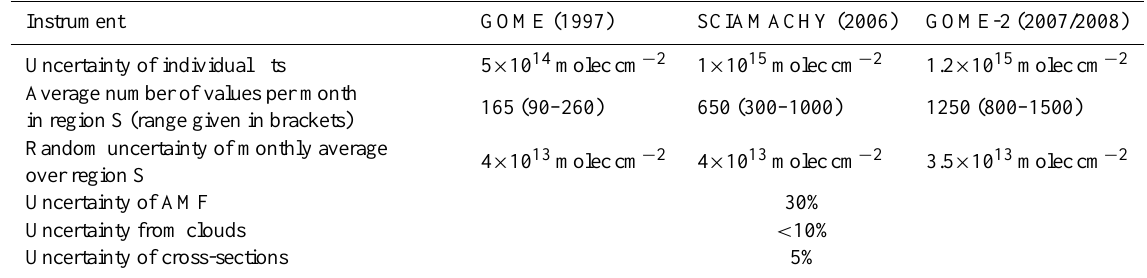
Table 2. Overview on estimates of random and systematic uncertainties in the satellite data. Random errors are estimated from data for one year for average sampling; the spread of values between months is given in